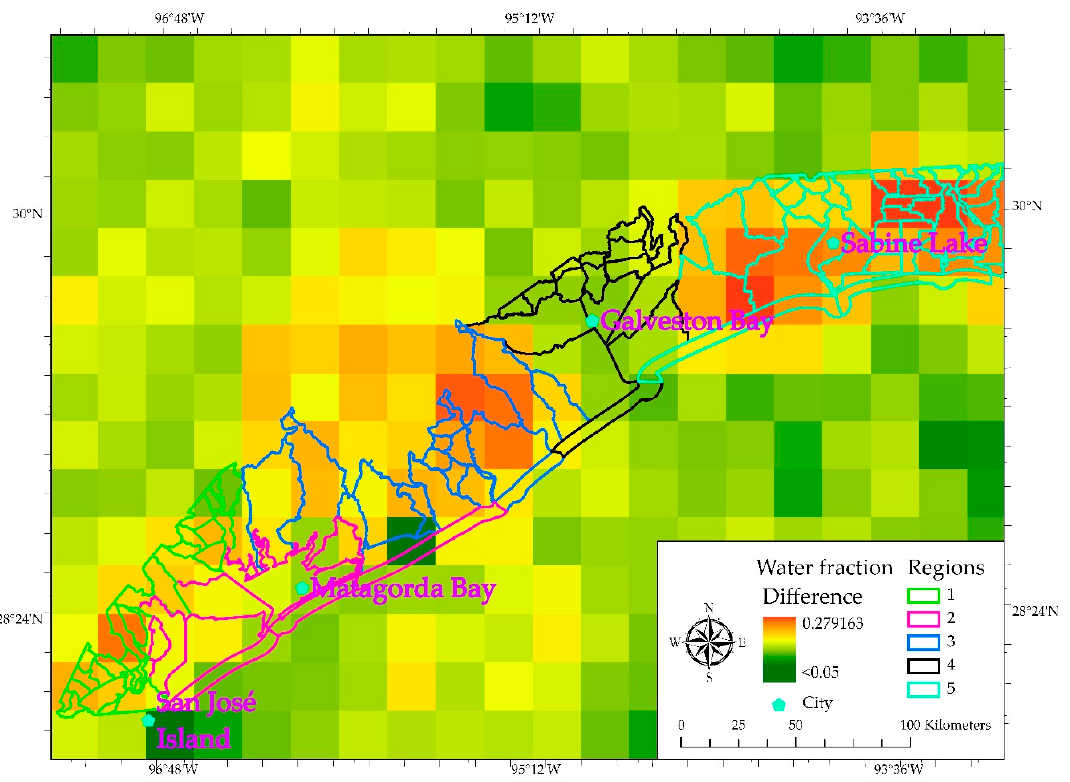
ISPRS Int. J. Geo-Inf. 2019 , 8 , 231 Figure 6. Water Fraction (WF) di ff erence before and after Hurricane Harvey. Figure 6. Water Fraction (WF) difference before and after Hurricane Harvey.